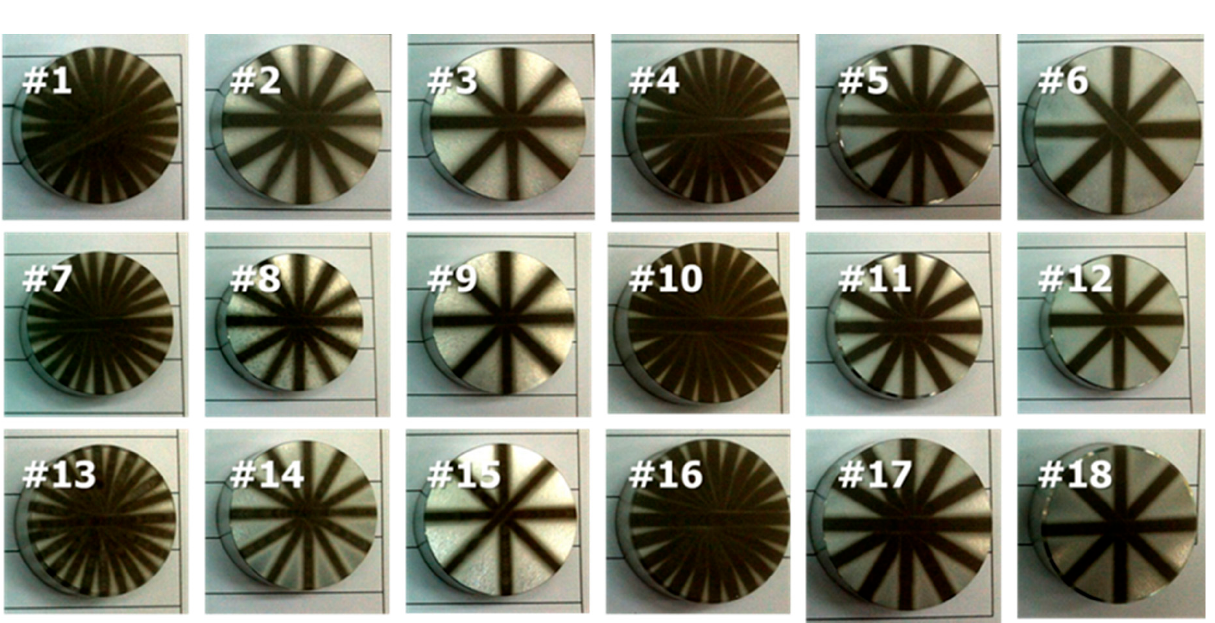
Figure 4. Images of samples machined using micro-AAJ.